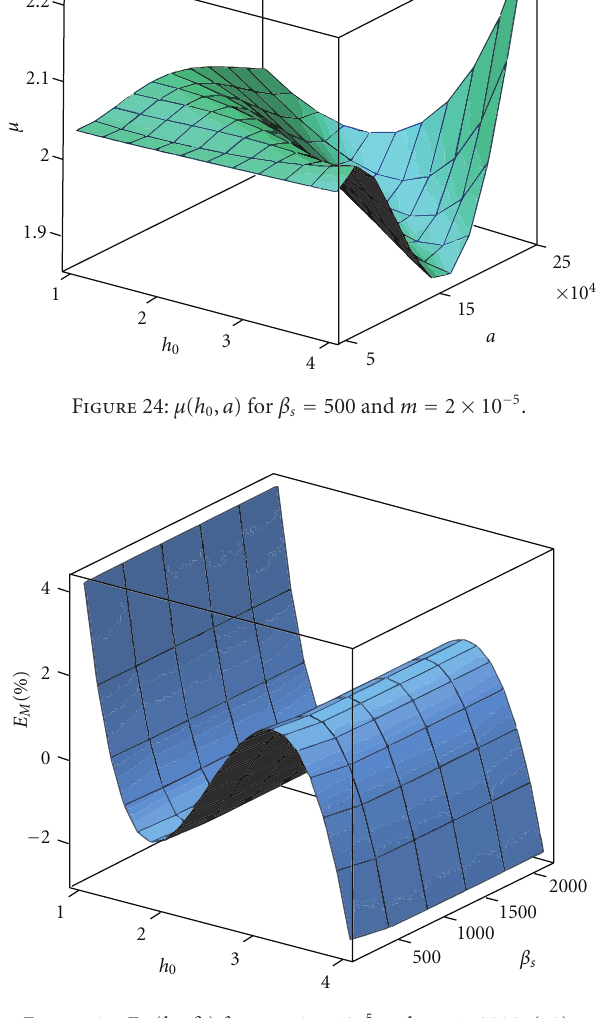
Figure 25: E M ( h 0 , β s ) for m = 2 × 10 − 5 and a = 150000 , (52).